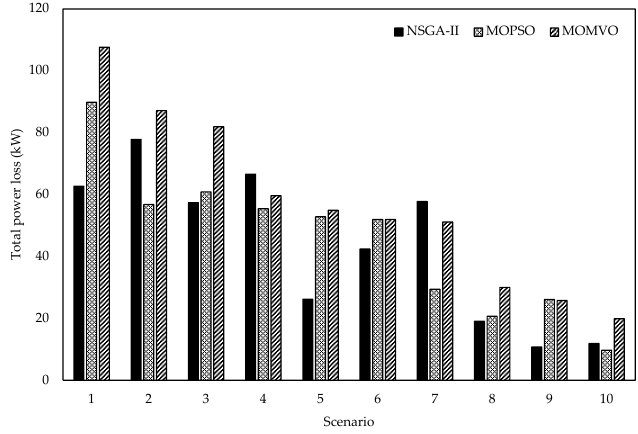
Figure 8. Total power loss for each scenario: 59-node distribution system.